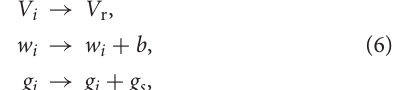
Frontiers in Physiology |